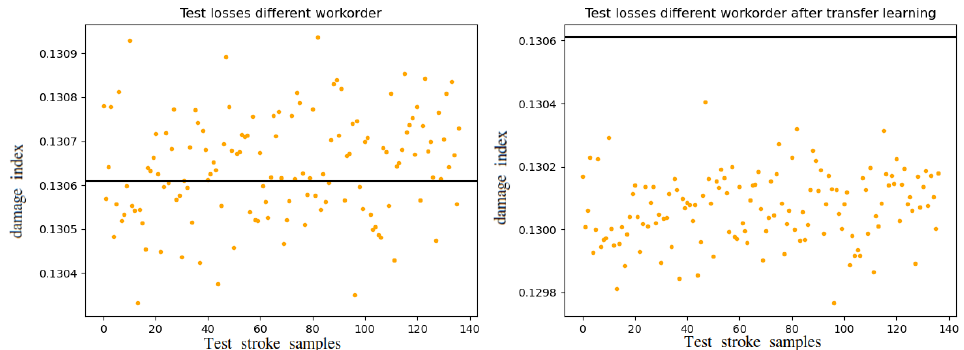
Figure 10. Damage indexes of correct test data before ( left ) and after transfer learning ( right ) using 2D-CNN-AE model in data of same die one week later. Horizontal black line represents the anomaly detection threshold.